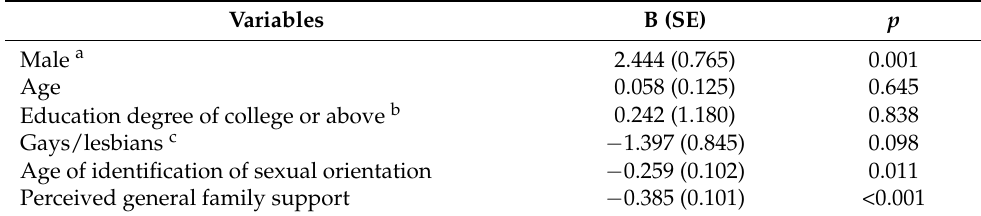
Table 2. Factors related to sexual orientation microaggression: Multivariate linear regression analysis.